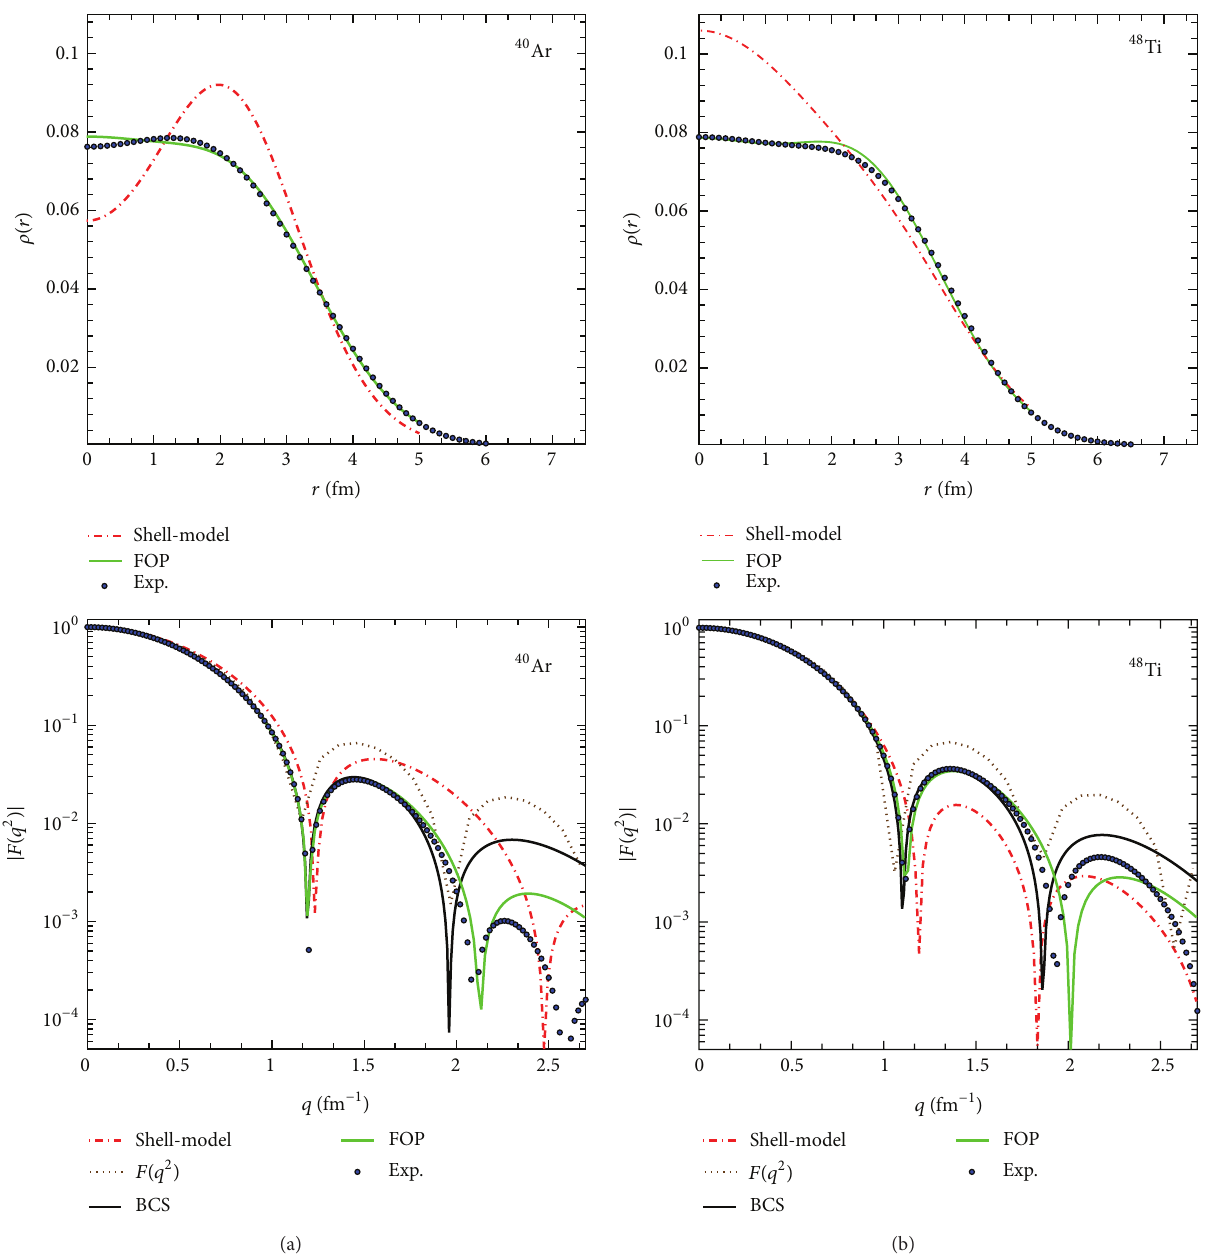
Figure 2: The charge density distribution (a) and the form factor as a function of the momentum transfer (b), for the cases of 40 Ar and 48 Ti nuclei. The introduction of fractional occupation probabilities (FOP) of the states provides higher reproducibility of the experimental data, compared to the simple shell-model and that of (21). The BCS nuclear neutron form factor 𝐹 𝑁 (𝑞 2 ) is also presented and compared.